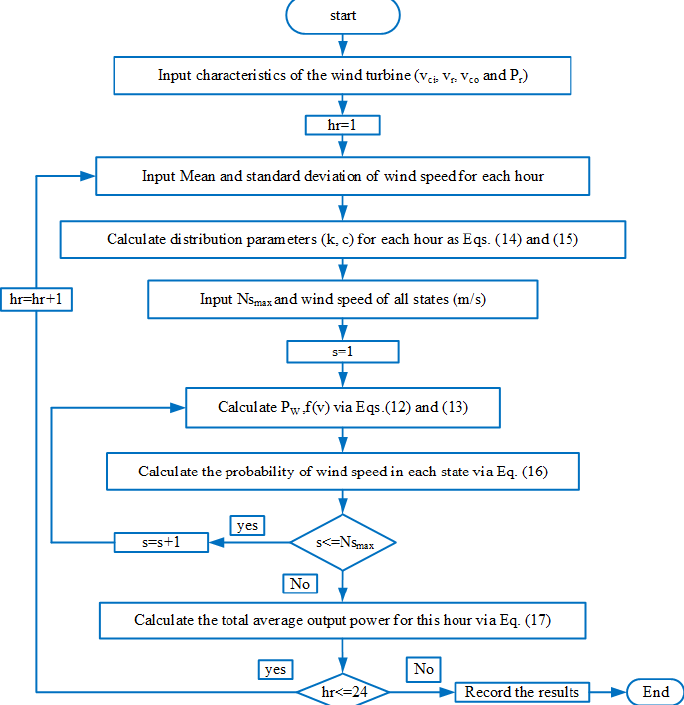
Figure 2. Evaluation of WT output power considering the uncertainties in wind speed.